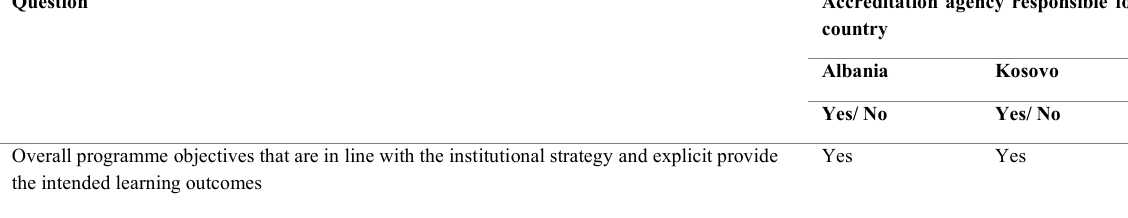
Table 12 : Internal quality assurance: Requirements of the KAA and QAAHE towards design and approval of programmes